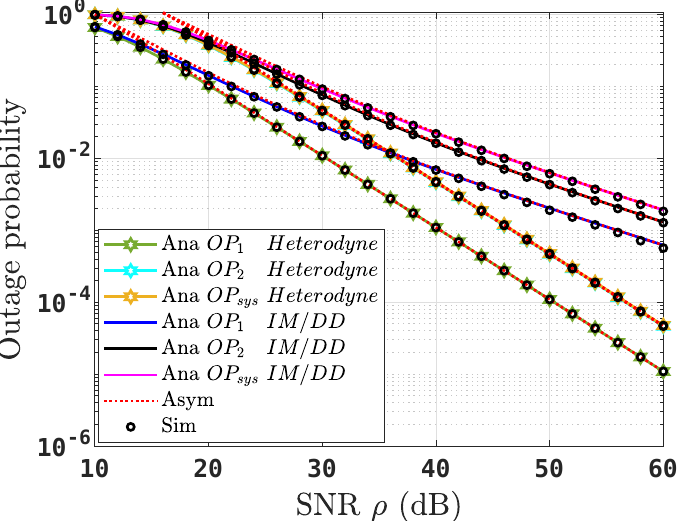
Figure 2. OPs versus SNR for thermally uniform UOWC links for both IM/DD as well as hetero- dyne